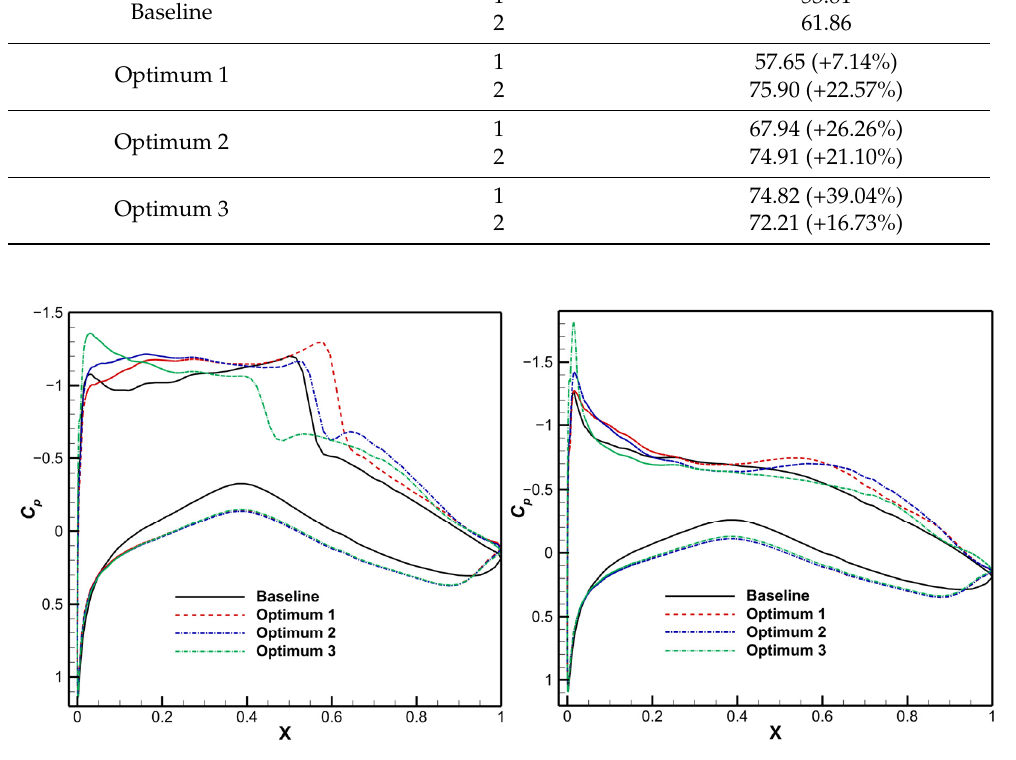
Figure 12. Comparison of pressure coefficient distribution between optimized airfoil and baseline.